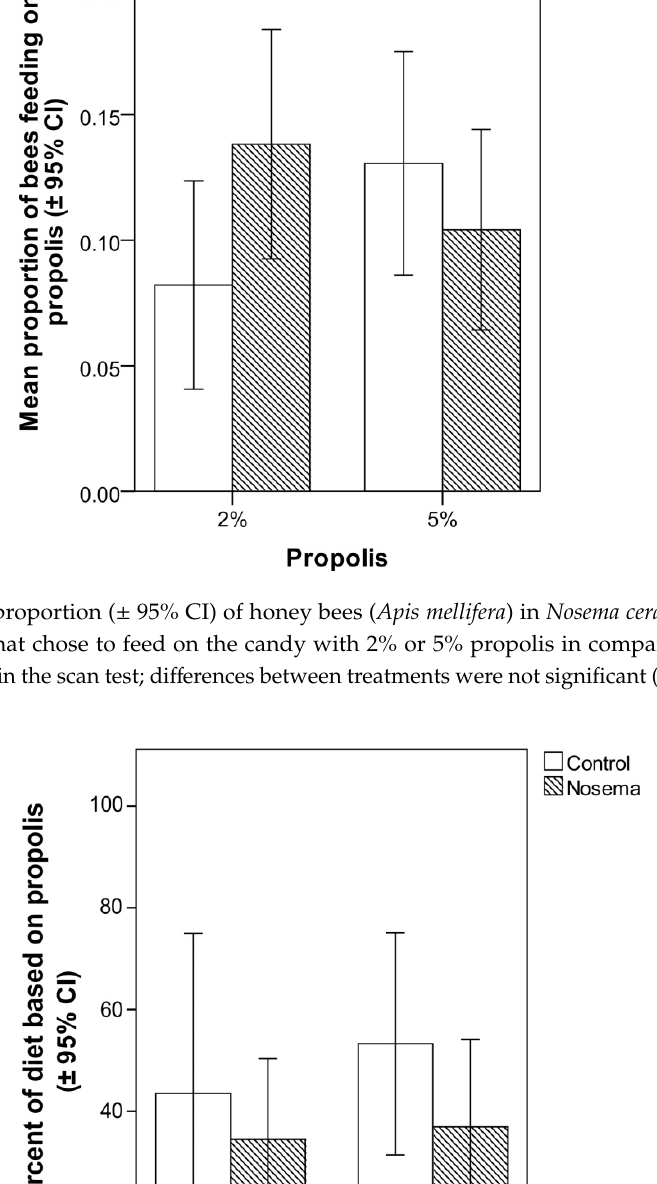
Figure 4. Mean proportion (± 95% CI) of honey bees ( Apis mellifera ) in Nosema ceranae -infected and control groups that chose candy with 2% or 5% propolis in comparison with candy without propolis in the choice test; differences between treatments were not significant (GLMM, p > 0.05).